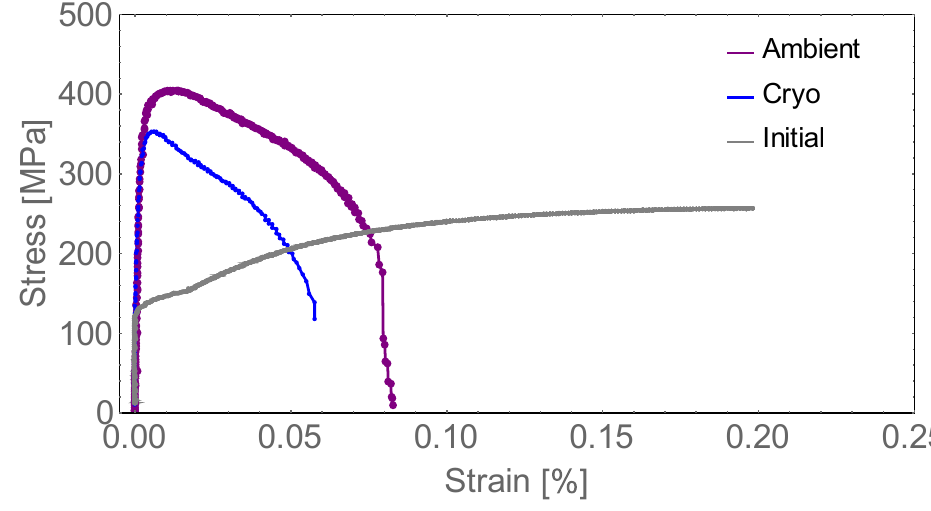
Figure 3. Tensile behavior for cryogenic SMAT (blue curve), ambient SMAT (purple curve) iron, and untreated iron plate (gray curve). The cryogenic SMAT exhibits lower strength and ductility than the ambient SMAT. Both SMAT treated plates show improvement in strength and decrease in ductility as compared to the untreated